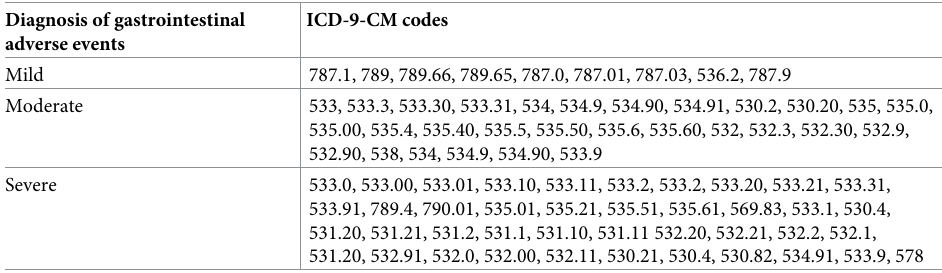
Table 1. ICD-9-CM codes for severity of gastrointestinal adverse